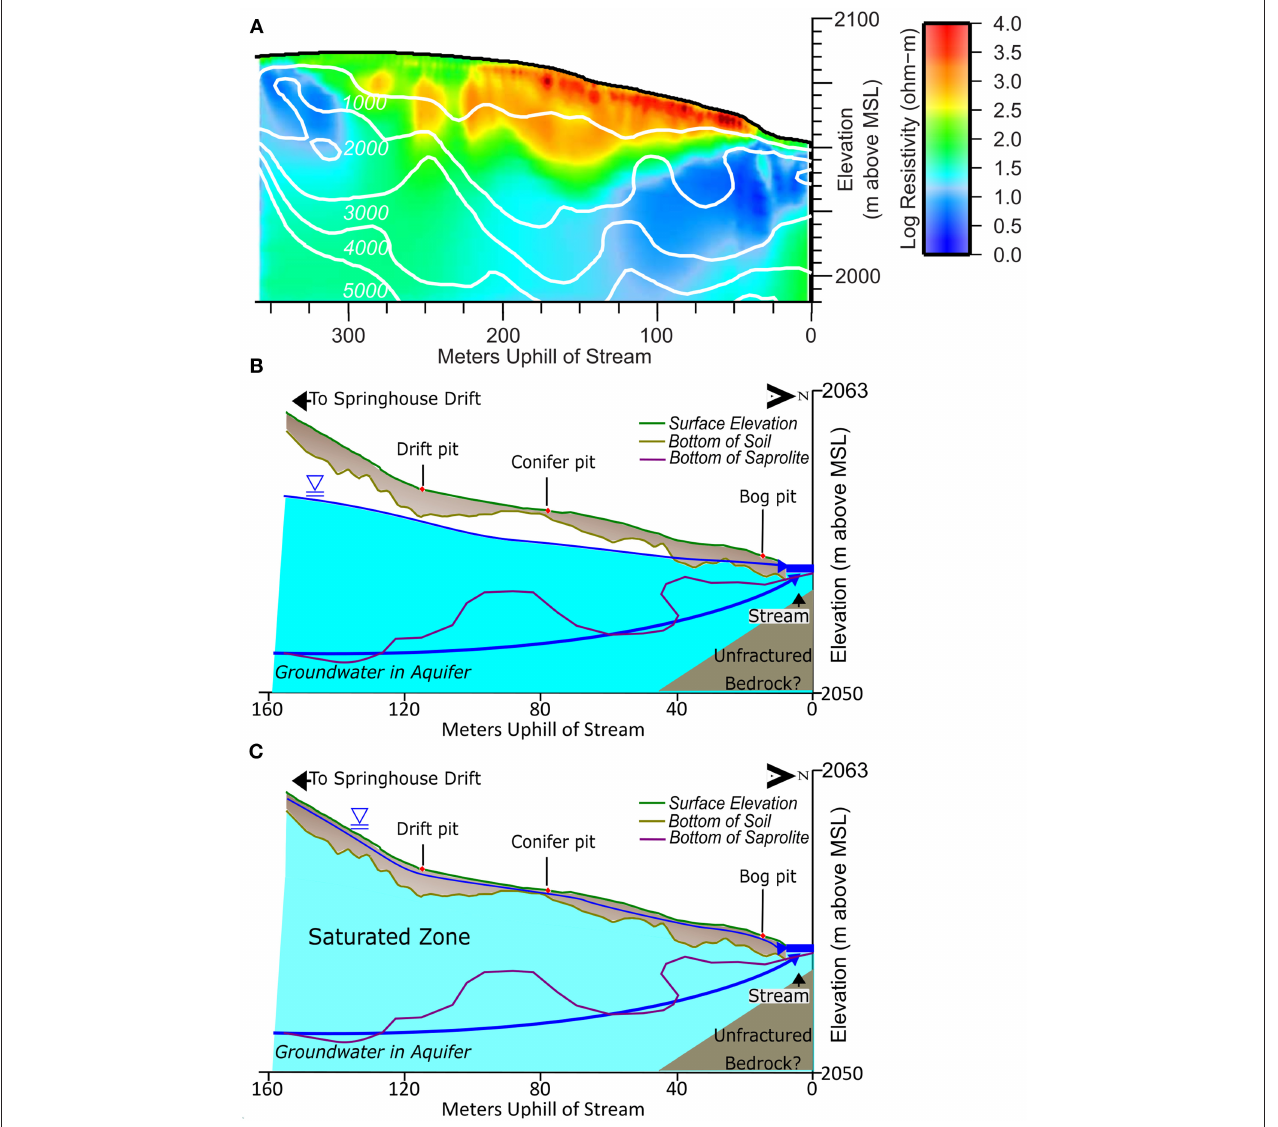
FIGURE 9 | Geophysics results and conceptual models of RME. X-axis is distance from the main stem of Reynolds Creek; the Bog pit is located at a secondary channel. (A) Color scale shows log 10 electrical resistivity according to color bar at left. White lines show seismic velocity contours from seismic inversion (italicized numbers in m/s). (B,C) Water table elevation in late summer compared to during snowmelt. Summer water tables (B) are lower, leaving soil water stranded in the unsaturated zone and unable to reach the stream. With the onset of melt, the water table rises (C) and soil water is flushed to the stream. Groundwater in aquifer may be sourced from an adjacent catchment. Note that conceptual figures represent a transect passing through the soil pits which is slightly offset from the geophysical transect, hence the difference in slope profiles; they also represent a shorter horizontal distance from the